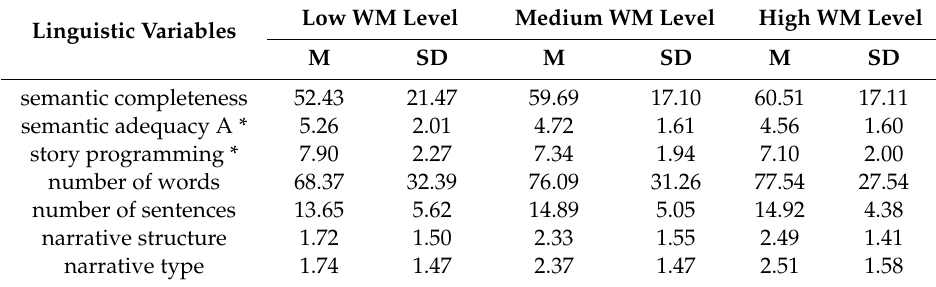
Table 3. Significant di ff erences in linguistic variables in preschoolers with di ff erent levels of general working memory